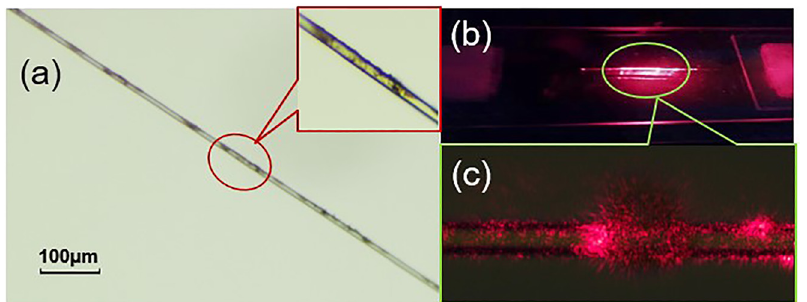
Figure 4: (a) Images of GDY-decorated mi- crofiber under microscope. Illustration shows the closeup views of GDY. (b) The composite structure under red light. (c) The closeup views of (b) under